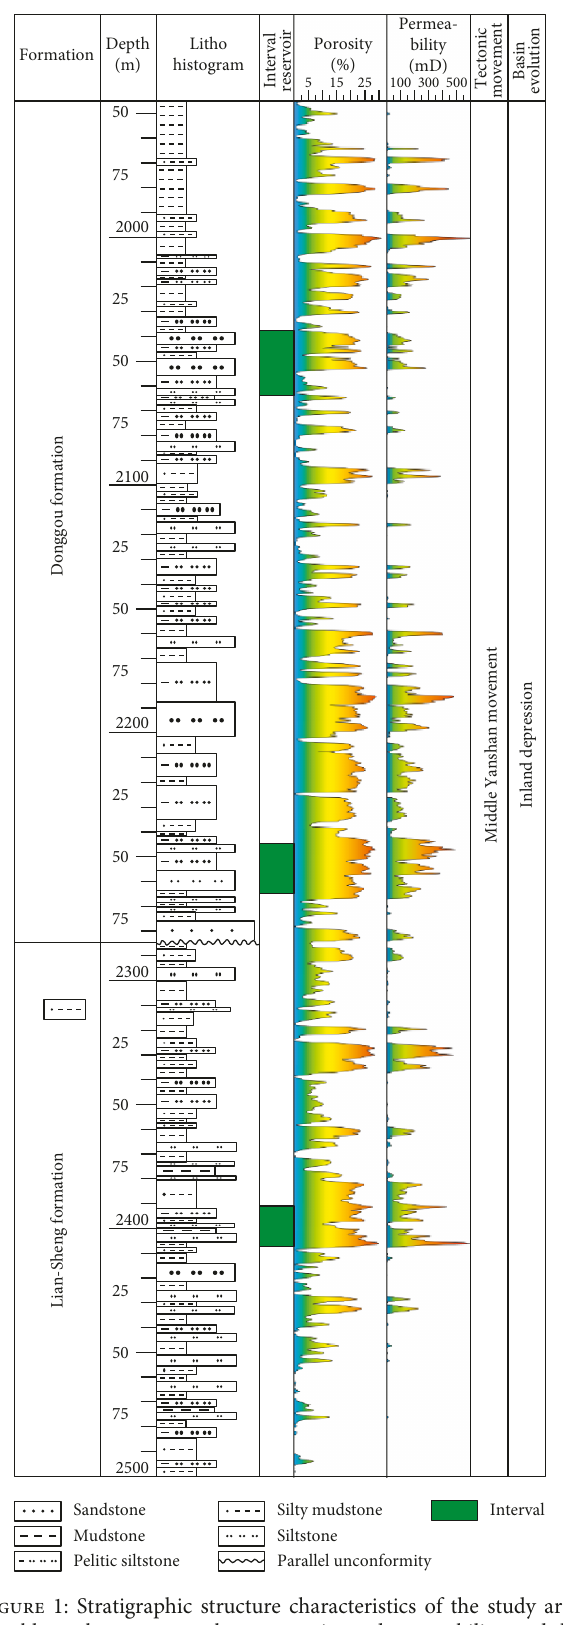
Figure 1: Stratigraphic structure characteristics of the study area (the blue color represents lower porosity and permeability, and the orange color represents higher porosity and